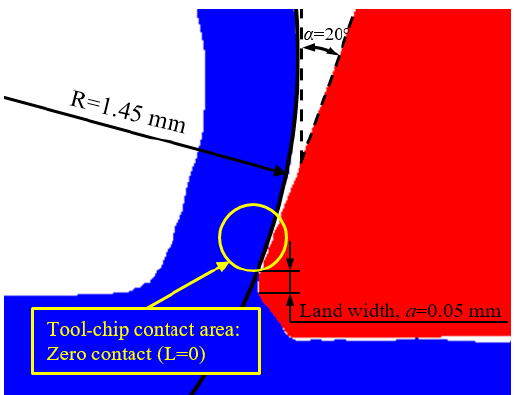
Figure 5. Detail of the area close to the cutting edge for the selected design: α = 20°, a = 0.05 mm.